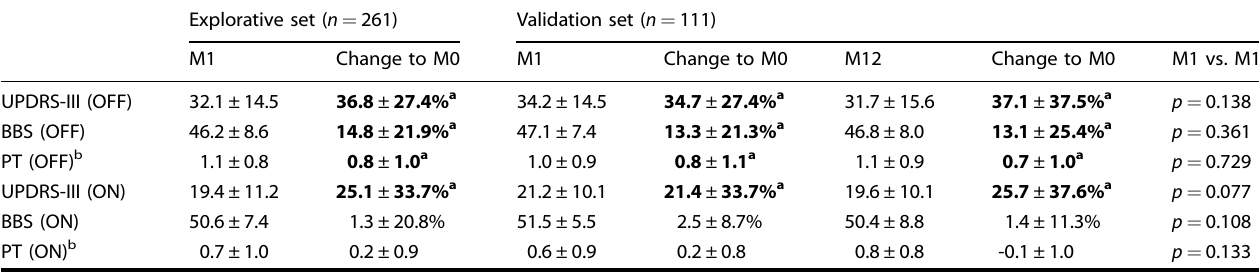
Table 2. Motor and balance change between baseline and follow-ups in the explorative and validation datasets. Explorative set ( n = 261) Validation set ( n =